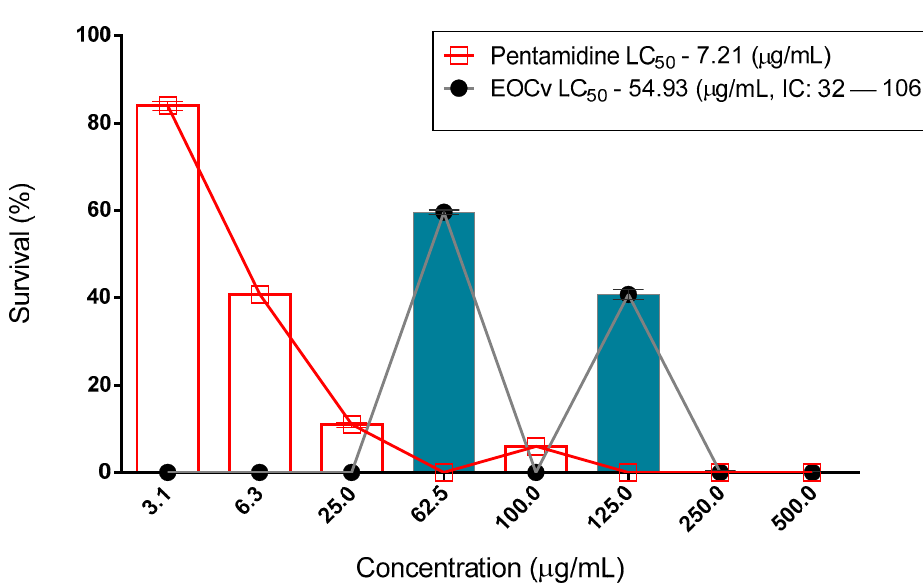
Molecules 2021 , 26 , x FOR PEER REVIEW Figure 2. Survival of the promastigote L. brasiliensis treated with C. verbenaceae essential oil. LC 50 confidence interval for oil 95% (32–106). EOCv (essential oil of C. verbenaceae ). According to Table 3, the EOCv at a concentration of 31.5 μ g/mL, managed to be lethal at approximately 70%, thus presenting a good anti ‐ leishmanial activity. Table 3. Survival of the promastigote L. brasiliensis treated with C. verbenaceae essential oil. Natural Product